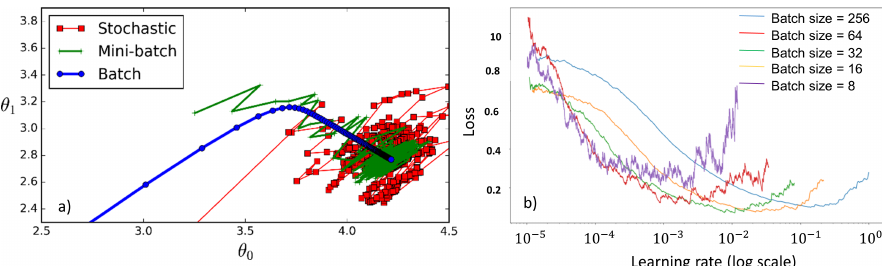
Figure 11. ( a ) Effects of batch sizes and ( b ) Relationship between learning rate error plotted using batch sizes of 8–256 for the docking station